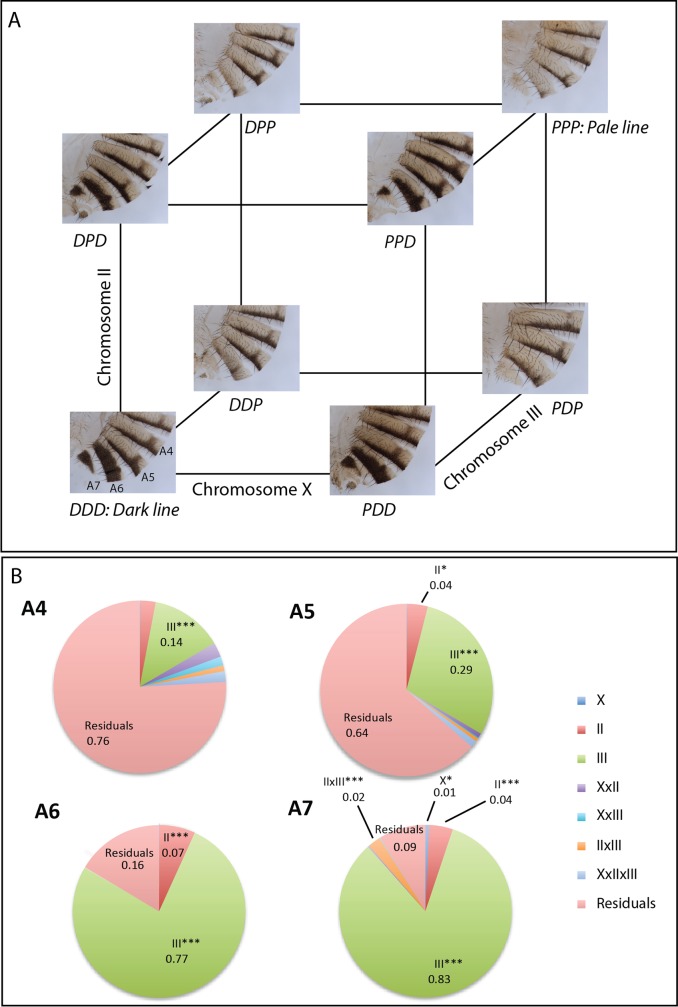
Chromosome III accounts for most of the difference of pigmentation between the Dark and Pale lines.A: Cuticles of flies, raised at 25°C, bearing the 8 combinations of X, second and third chromosomes from the Dark and Pale lines. Hemi-tergites A4 to A7 are shown. The horizontal axis represents the X chromosome, the vertical axis the second chromosome, and the oblique axis the third chromosome. Each line is named from the chromosome it contains (for example, DPD: X and third chromosome from the Dark line, second chromosome from the Pale line). By eye, a strong effect of the third chromosome is noticeable. B: Pie charts of the Eta squared values (h2) obtained from quantification of pigmentation in the 8 lines (n = 10 per line). The effects of each chromosome and their interactions are shown for A4, A5, A6 and A7 segments. When the effects are significant, Eta squared values are indicated on the pie. Residuals: variation not accounted by the model. *: 0.01<p<0.05; ***: p<0.001. Statistical test: three-way ANOVA with full factorial model.